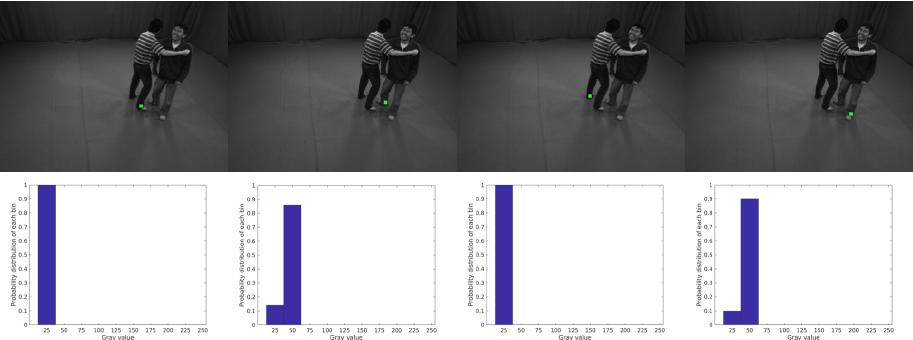
Figure 3. Symmetry Ankle Joints